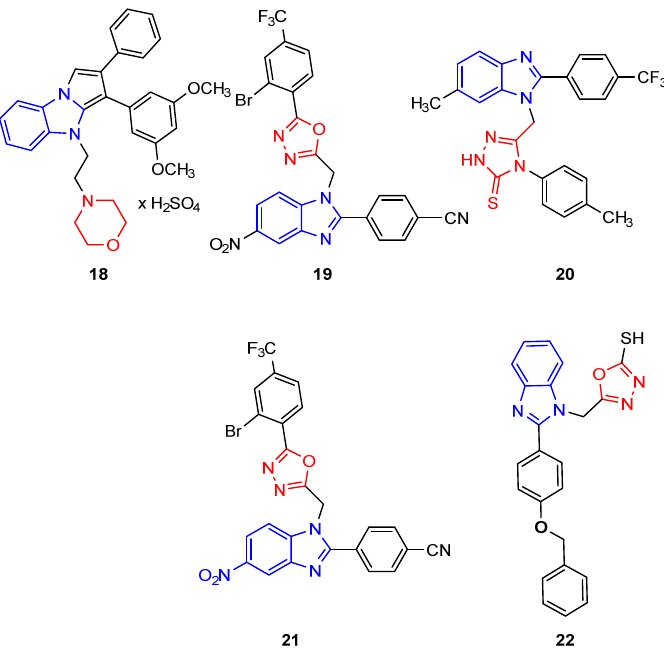
Figure 16. Pyrrolo, pyrazole, triazole, and oxadiazole–benzimidazole derivatives. Similarly, a series of 2-(Thiophen-2-yl)-1-((thiophen-2-yl)methyl)-1H-1,3-benzimid-